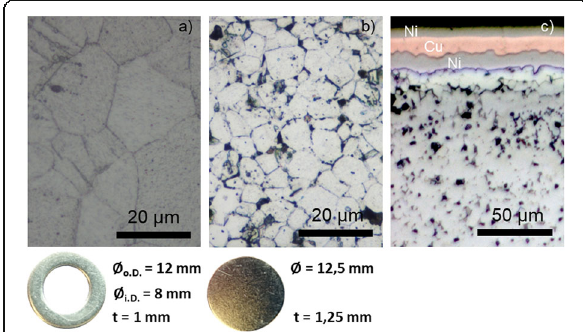
Fig. 2 Microstructure of the initial joining partners a 316L stainless steel flat ring, b Nd 2 Fe 14 B round plate including c a Ni/Cu/Ni coating against corrosion